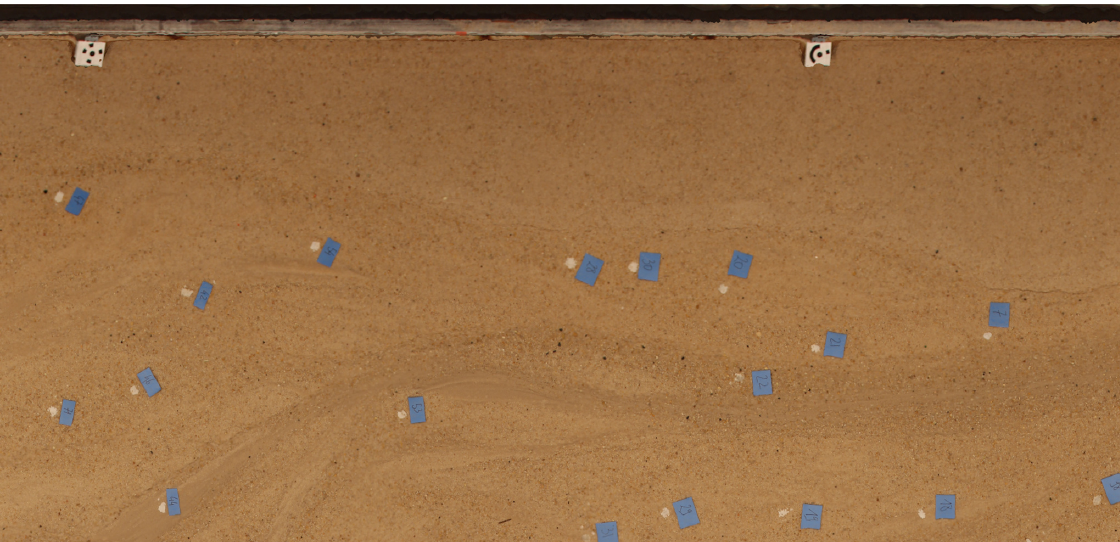
Figure 10. Image of the flume surface with the location of wax samples used for grain size validation.